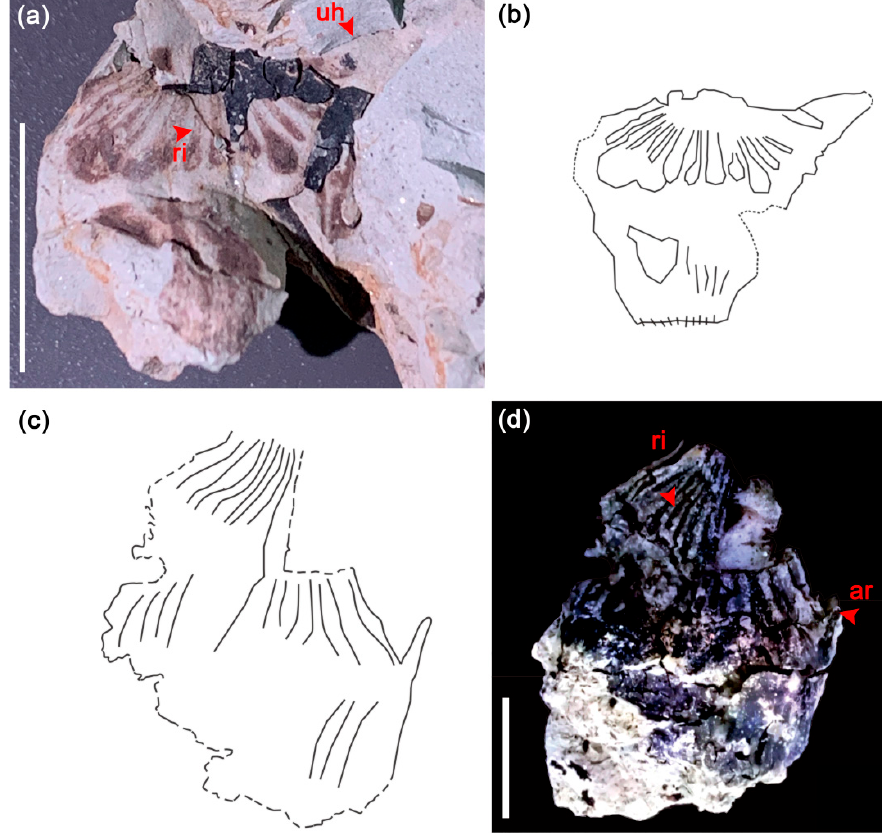
Figure 3. Fossil of Trapa sp. indet. and Hemitrapa sp. indet. ( a ) WN ‐ 0 ‐ 2 ‐ 60, fossil of Trapa sp. indet.; ( b ) Line drawing of Trapa sp. indet.; ( d ) WN ‐ 0 ‐ 2 ‐ 26, fossil fruit of Hemitrapa sp. indet.; ( c ) Line drawing of Hemitrapa sp. indet.; uh = upper horn, ar = arm, ri = ridges. Scale bars = 10 mm. Genus: Hemitrapa Miki 1941.